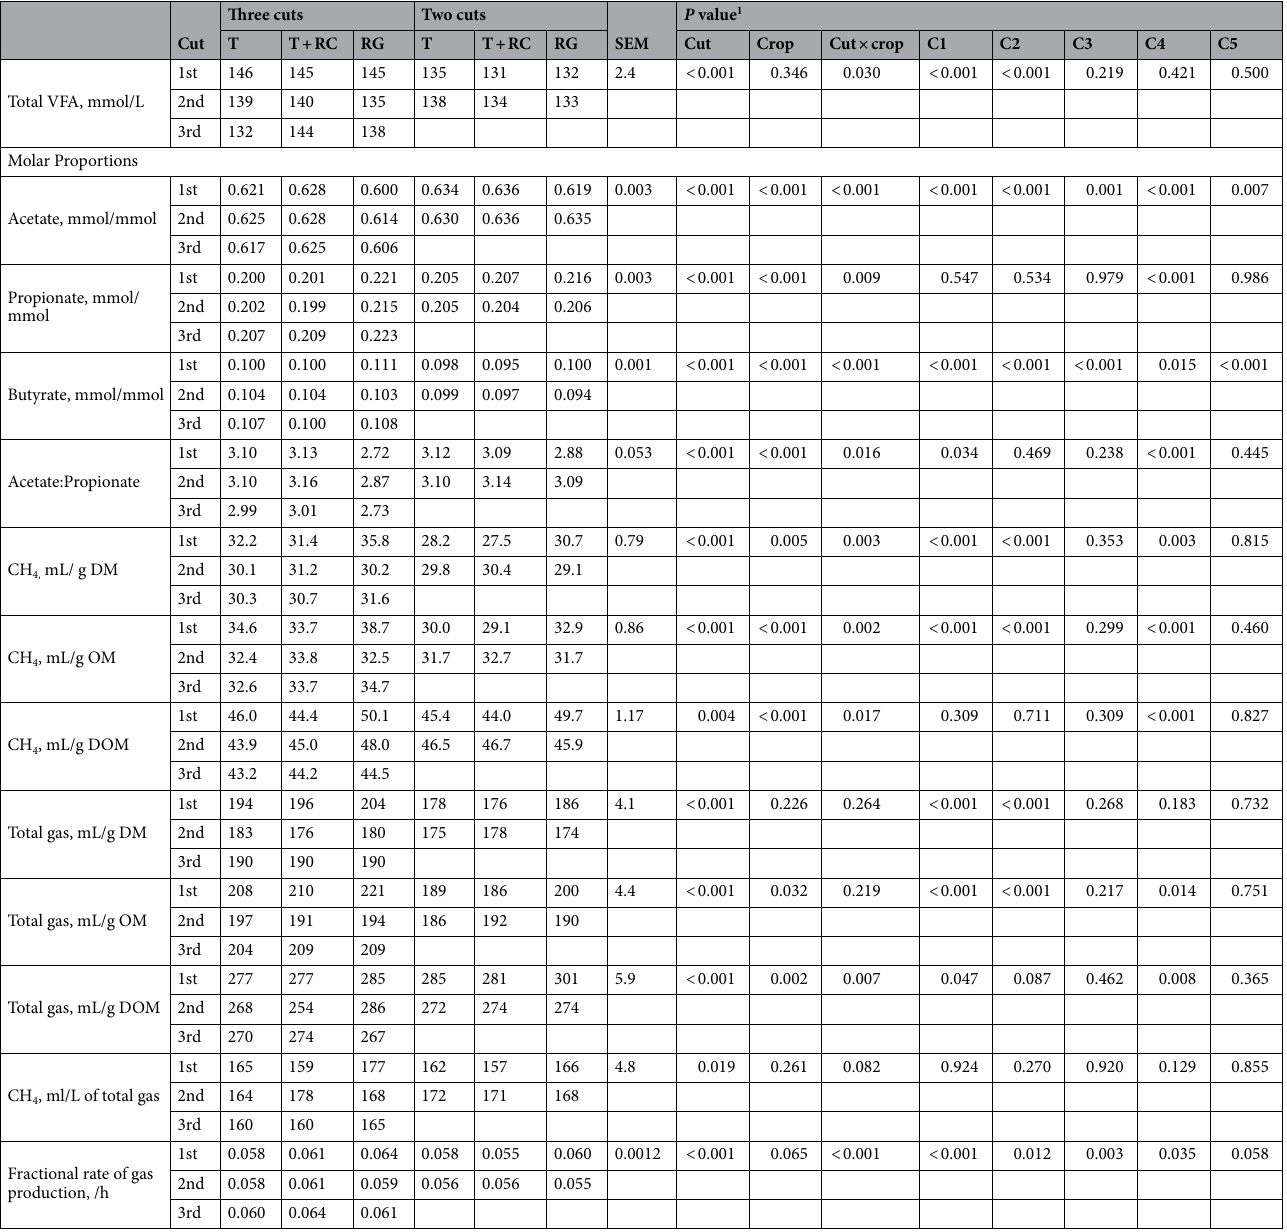
Table 6. Effect of Cut (1–5 where 1, 3 and 5 is the first, second and third cut in the three-cut system, and 2 and 4 is the first and second cut in the two-cut system) and crop (T, Timothy; T + RC, Timothy + red clover;